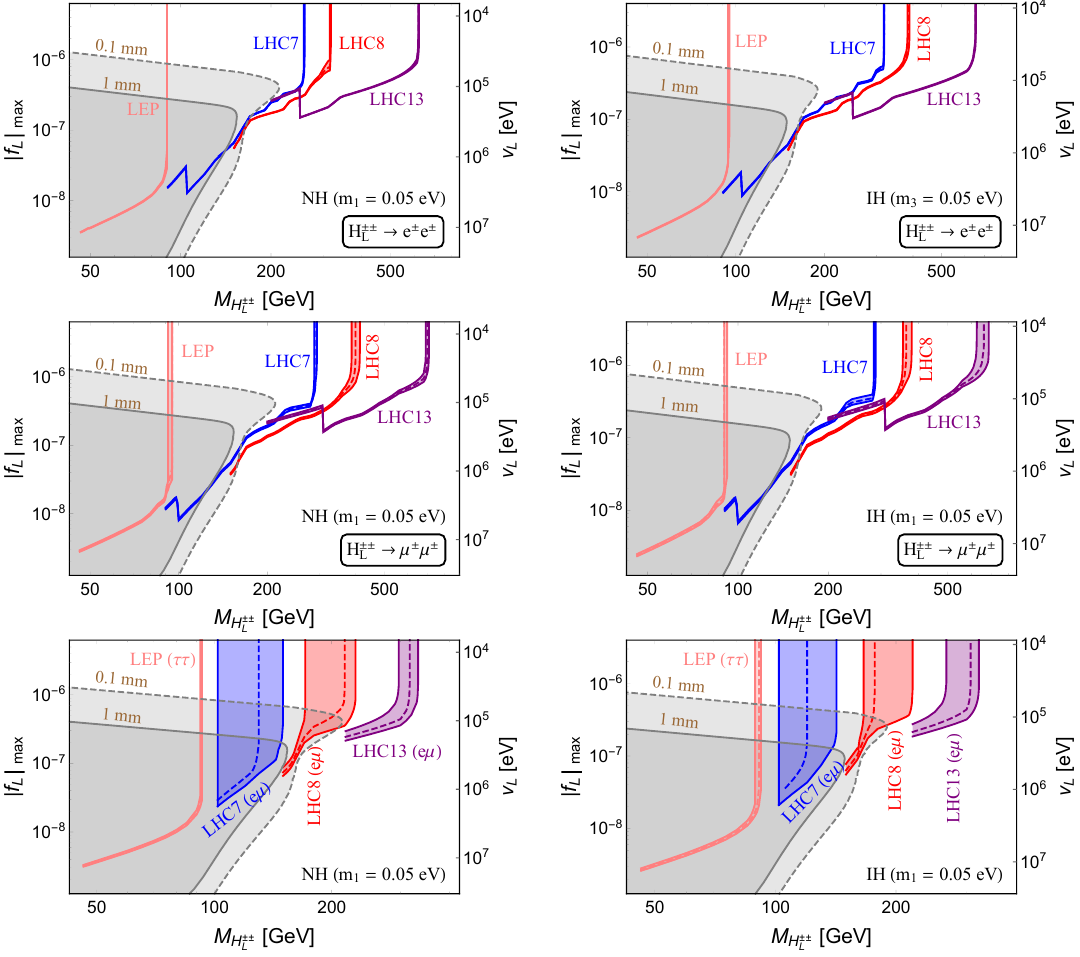
Figure 7 . Same as in (cid:12)gure 6, but for the NH case with m 1 = 0 : 05 eV (left) and IH with m 3 = 0 : 05 eV (right). The upper, middle and lower panels are respectively in the channels of ee , (cid:22)(cid:22) , e(cid:22) and (cid:28)(cid:28) for both NH and IH